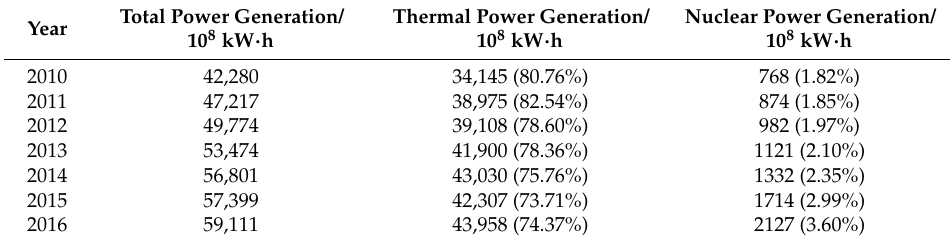
Table 1. Thermal power and nuclear power generation in